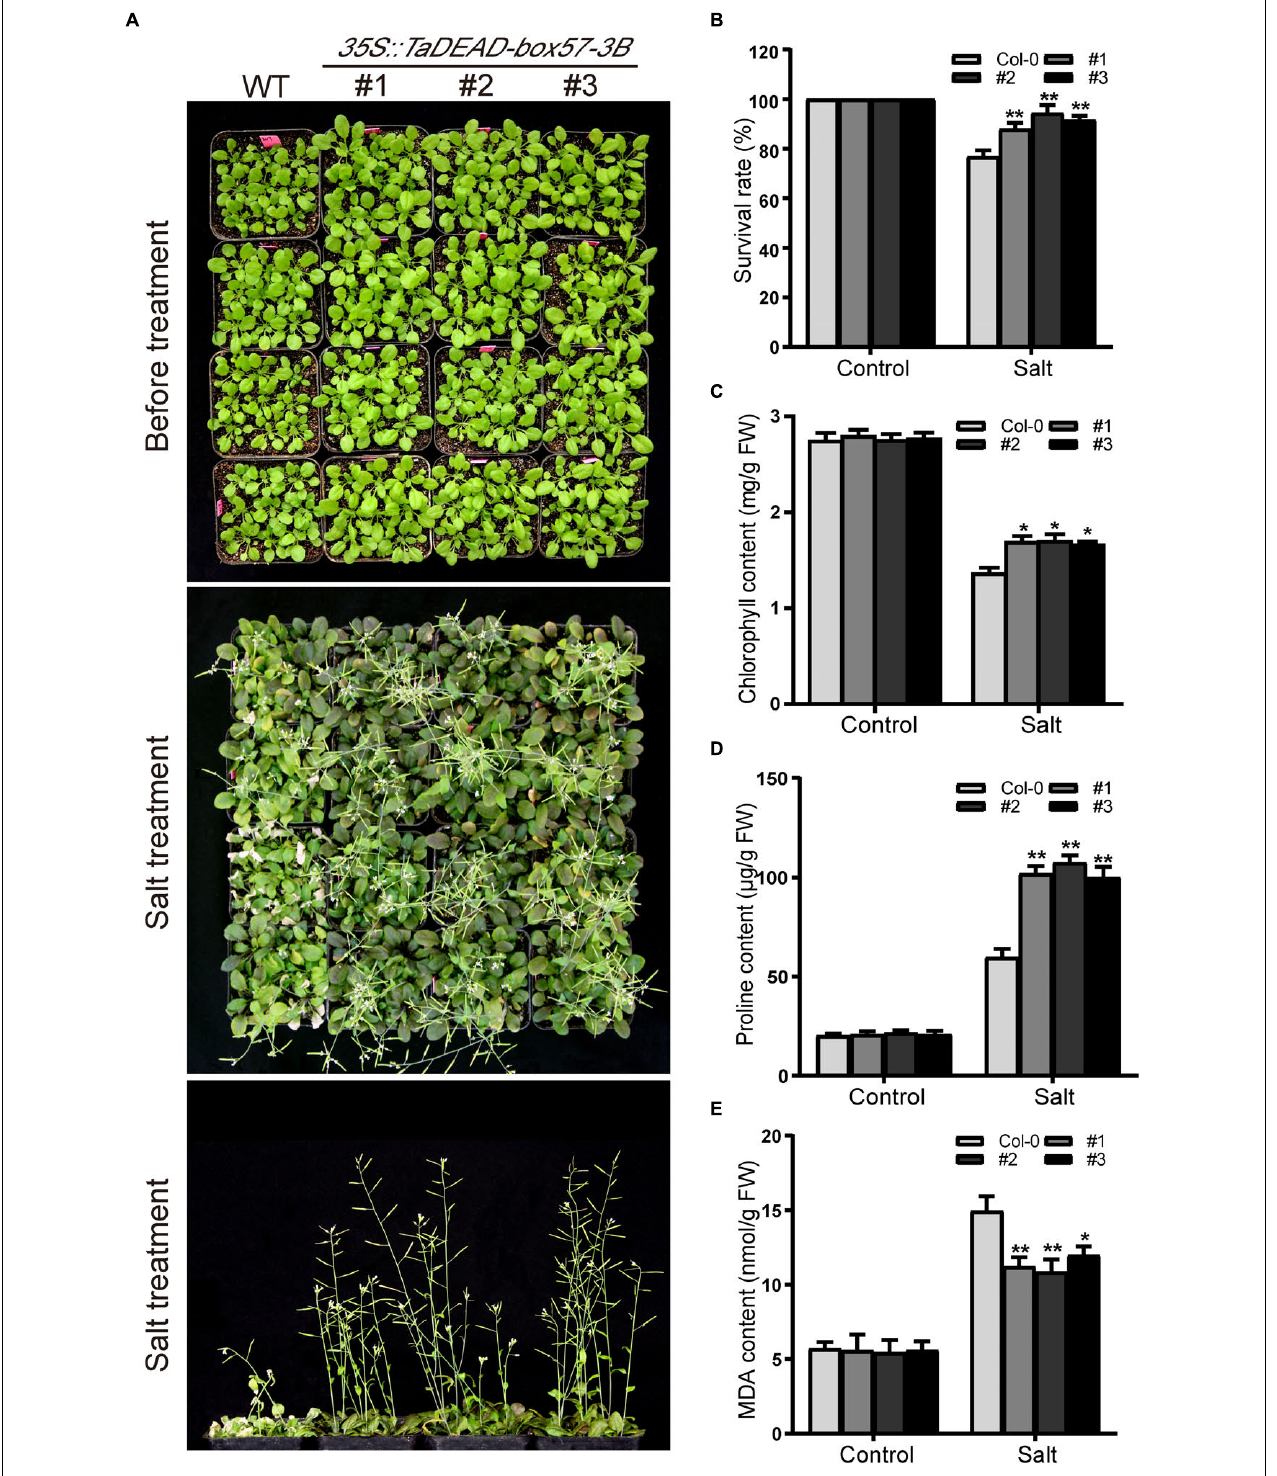
FIGURE 12 | Ectopic expression of TaDEAD-box57-3B increased salt resistance in transgenic Arabidopsis . (A) Phenotypes of 21-day-old WT and TaDEAD-box57-3B transgenic plants under salt stress. (B) The survival rates of WT and transgenic plants under salt treatment. (C–E) The physiological indicators of WT and transgenic plants under normal and stress treatments, including chlorophyll (C) , proline (D) , and MDA (E) contents. The data are shown as the means ± SD obtained from three biological replicates. ANOVA test was used to analyze significant differences (* p < 0.05, ** p < 0.01).